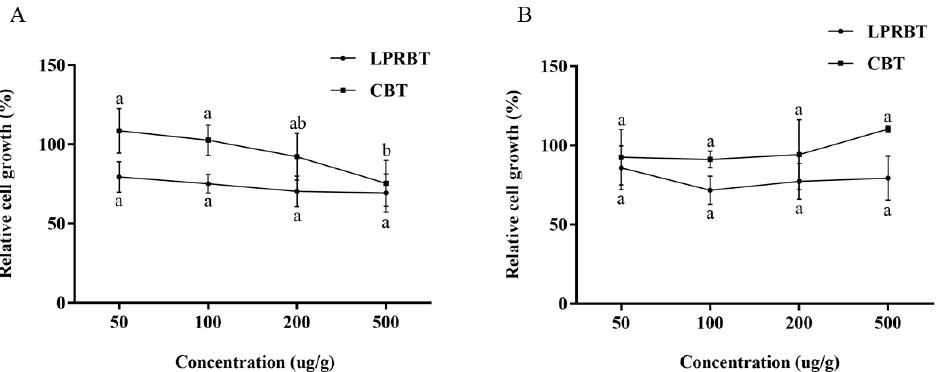
Figure 4. Effects of LPRBT and CBT on the vitality of cancer cells. ( A ) Effects of LPRBT and CBT on the vitality of Hela cells; ( B ) Effects of LPRBT and CBT on the vitality of A549 cancer cells. CBT: traditional black tea; LPRBT: L. polystachyus black tea. Error bars indicate standard error (SE). Letter designations identify homogeneous groups. Different letters represent significant differences ( p < 0.05). The same letter means there are no statistically significant differences between the means ( p > 0.05).